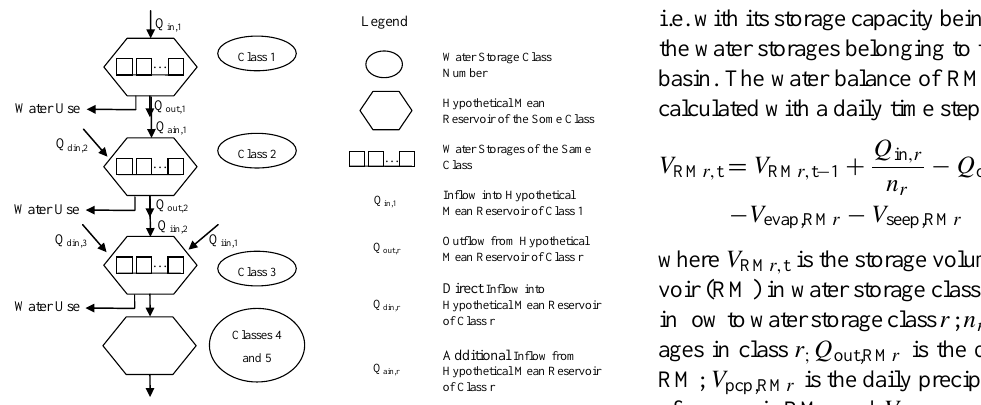
Fig. 2 Sequential and parallel routing scheme for water storages in the improved Fig. 2. Sequential and parallel routing scheme for water storages in the improved SWAT2005